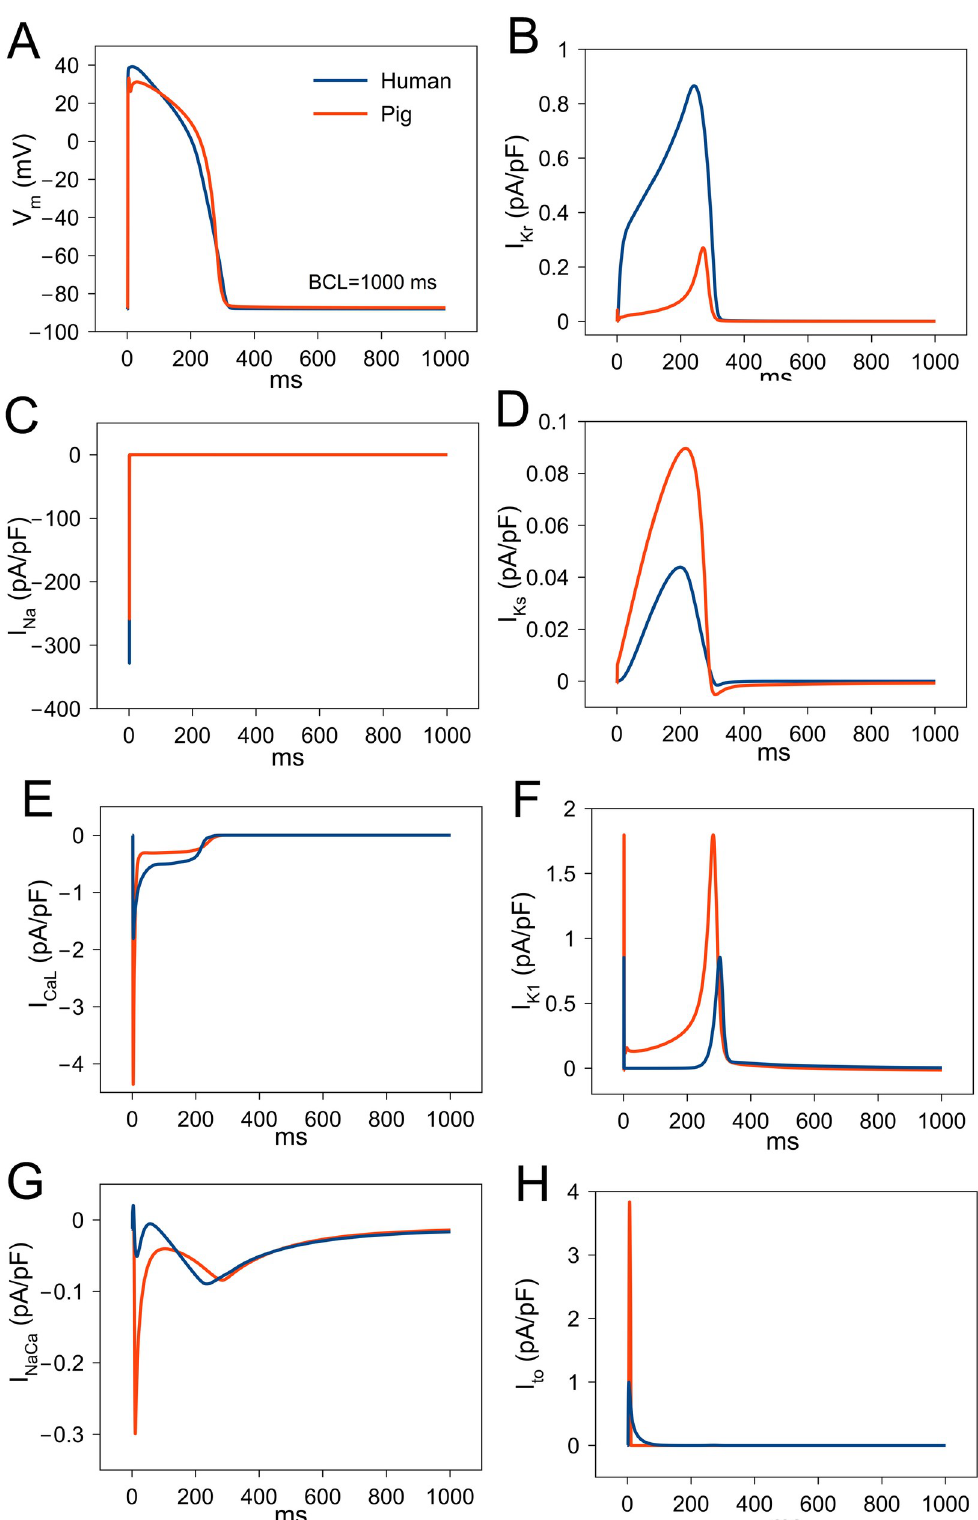
Fig 3. Comparison of simulated cardiac electrophysiological currents between human and pig ventricular myocyte during paced action potential (AP) at a basic cycle length (BCL) of 1000 ms. (A) AP. (B) Rapid delayed rectifier K